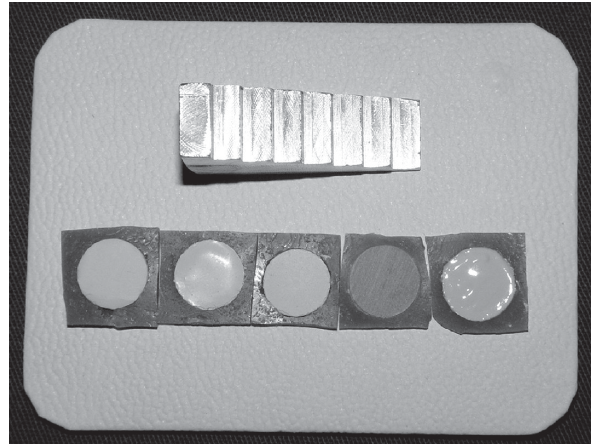
FIGURE 1- Occlusal film, specimens, and aluminum step wedge